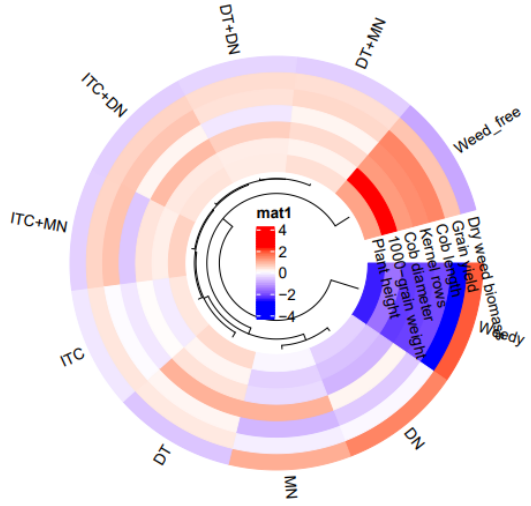
Figure 8. Heat map of the parameters corresponding to the treatments.